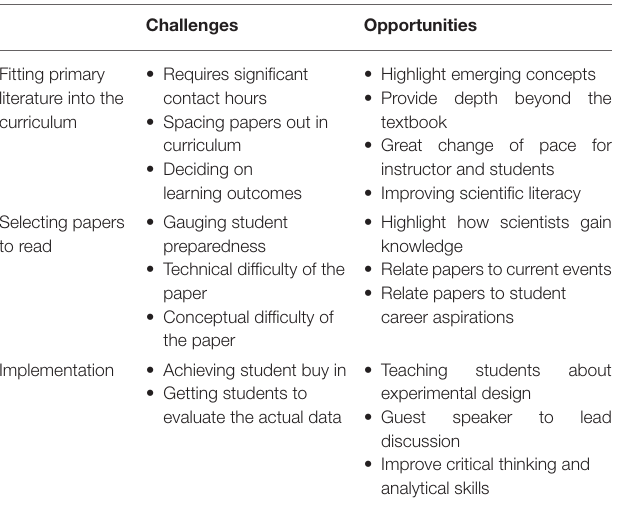
TABLE 1 | Summary of challenges and opportunities associated with incorporating primary literature into the undergraduate